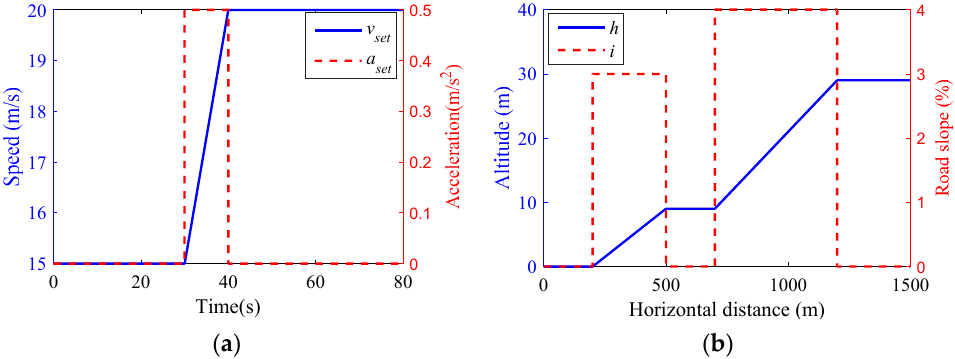
Figure 9. Profiles of leading vehicle movement and road slope in scenario 1. ( a ) Leading vehicle movement. ( b ) Road slope.